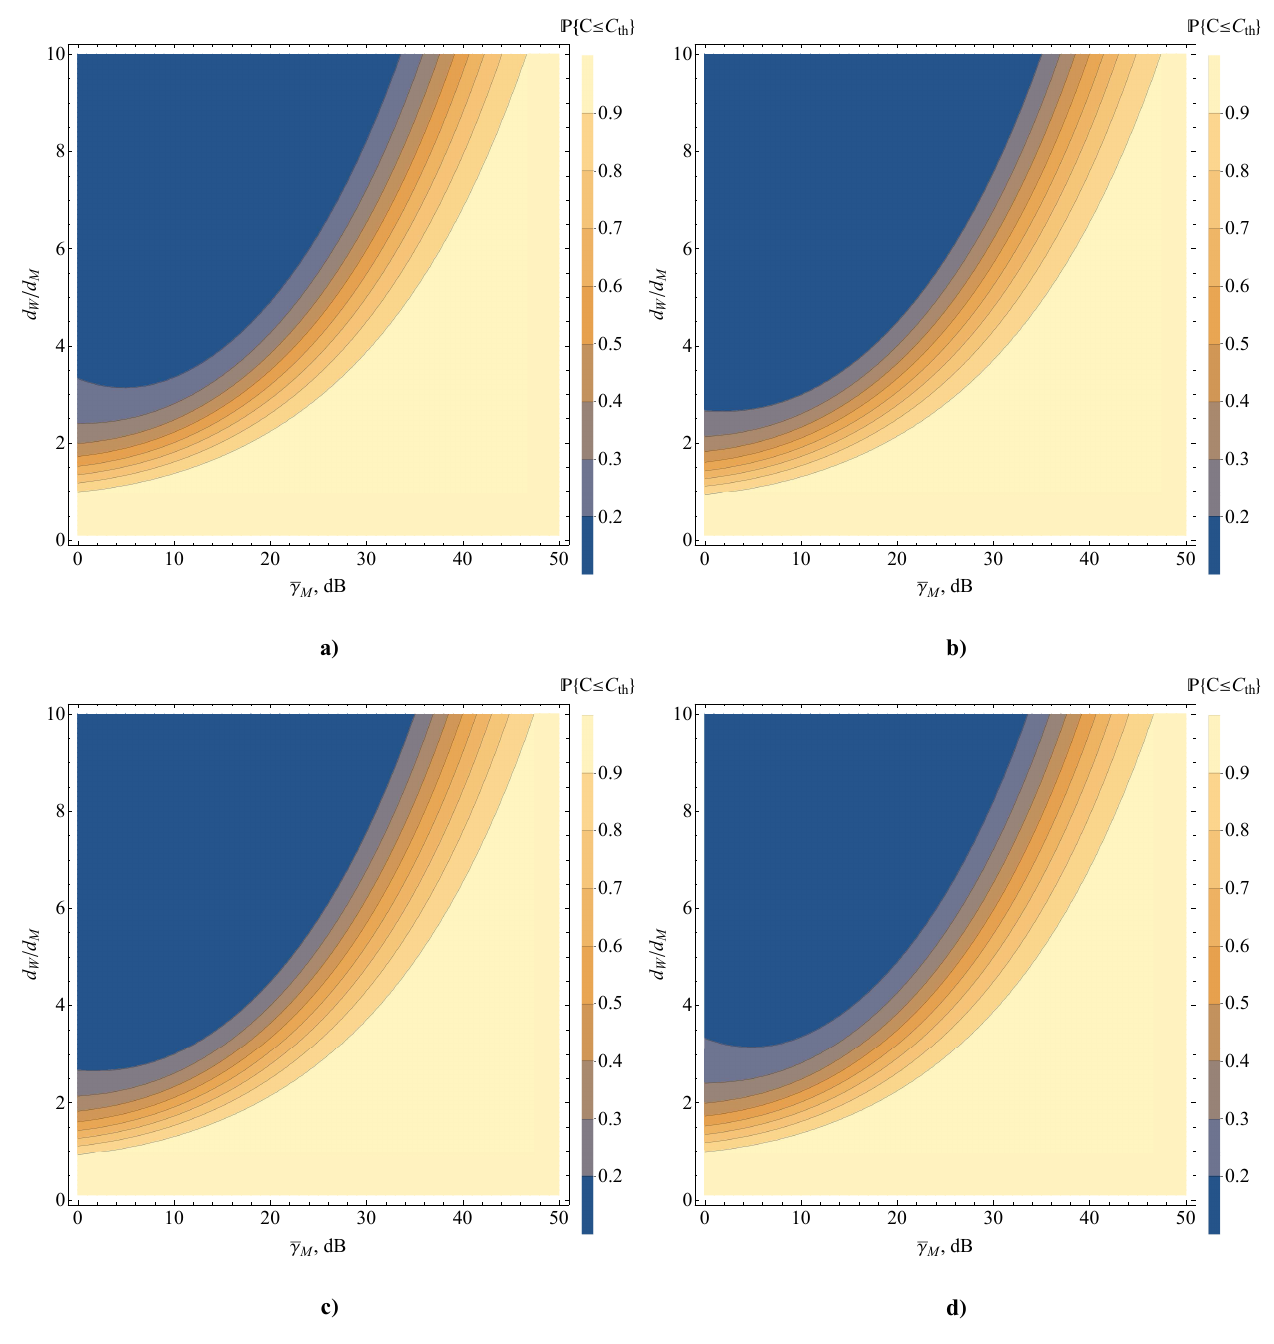
Figure 4. Secrecy outage capacity of the shadowed Beaulieu–Xie model for m X = 5, m Y = 5, C th = 0.5, α = 2 with: ( a ) Ω X = − 10 dB, Ω Y = − 10 dB; ( b ) Ω X = 10 dB, Ω Y = − 10 dB; ( c ) Ω X = − 10 dB, Ω = 10 dB; ( d ) Ω = 10 dB, Ω = 10 dB. X Y Y Analyzing contour plots with one of the arguments being constant, one should keep in mind the relationship (4) between the parameters of the system model. With a constant (cid:113) (cid:14) (cid:14) d M = const we have α ¯ γ M ¯ γ W = const , this means that the increase in ¯ γ M ratio d W corresponds to either a proportional increase of ¯ γ W (i.e., facilitating the reception for the wiretap receiver), or an increase in the path loss exponent α (i.e., increasing attenuation and worsening the overall signal propagation conditions). Thus, while maintaining d W (cid:14) d M fixed, the increase of ¯ γ M leads to the increase of P out , which corresponds to and d W the impairment of the predicted security. For the constant average main channel